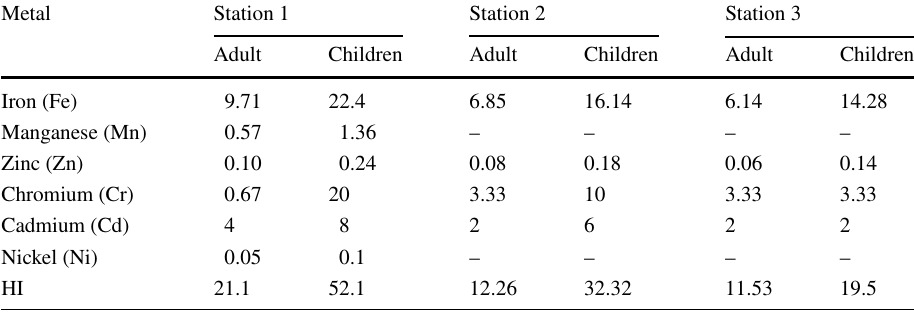
Table 5 Hazard quotients and total hazard index of the heavy metals